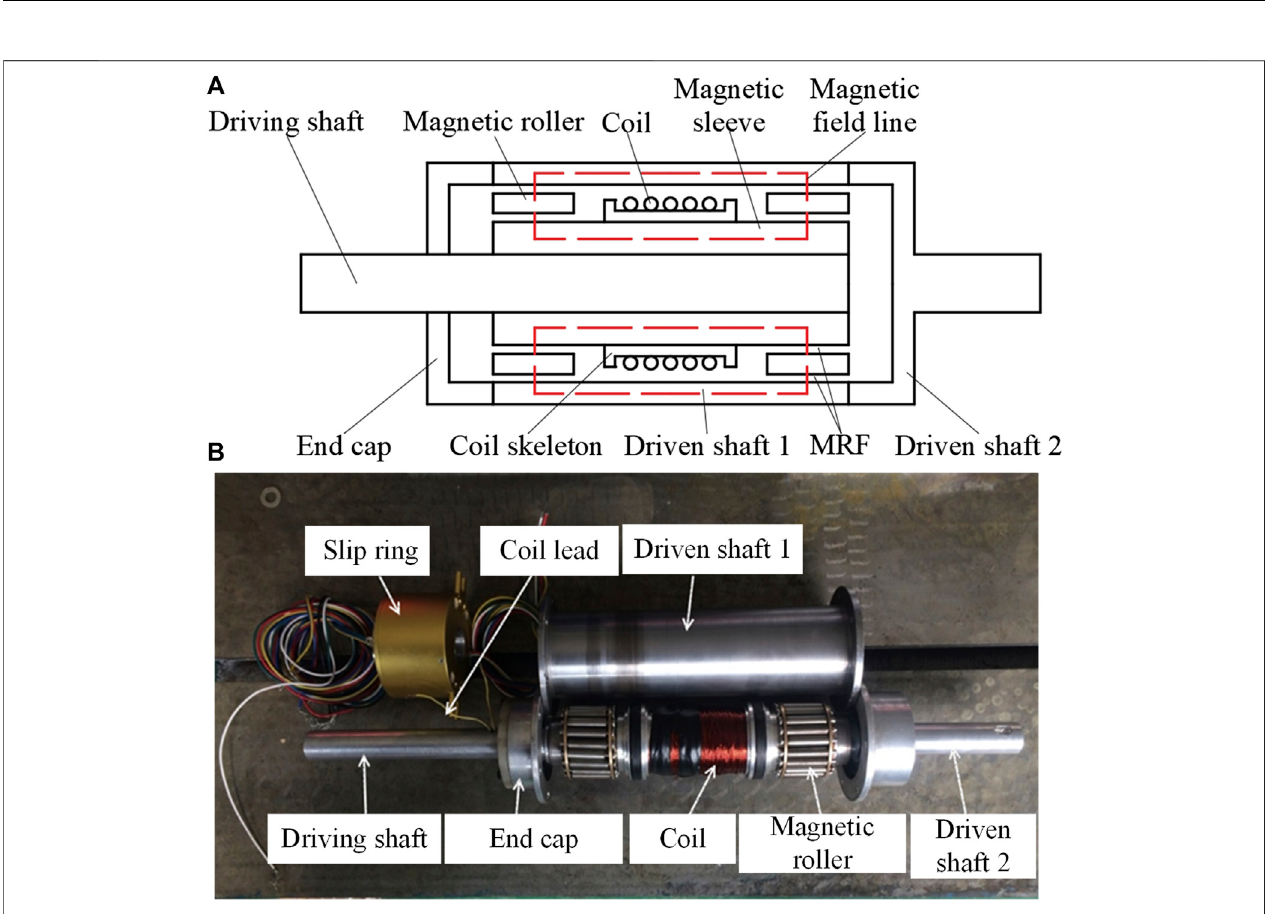
Frontiers in Materials |